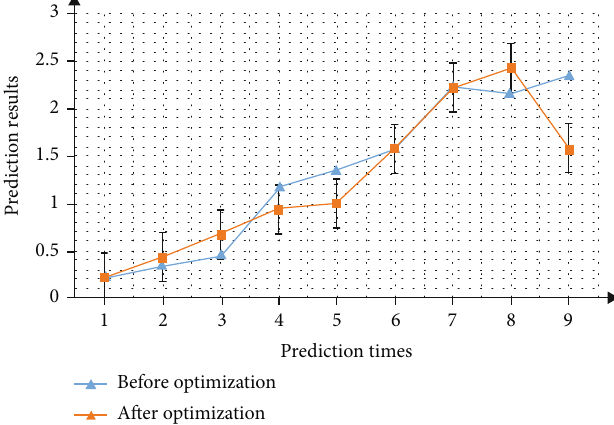
Figure 7: Prediction results of genetic